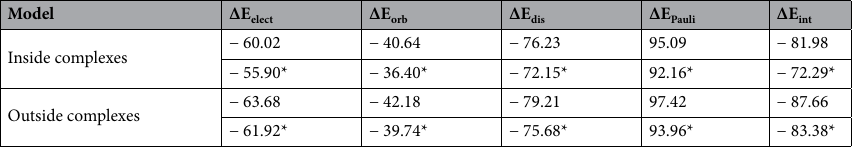
Table 2. Energy (kJ/mol) decomposition analysis of DOX-hexakis dimer complexes with B3LYP-D/DZP level of theory. *In water